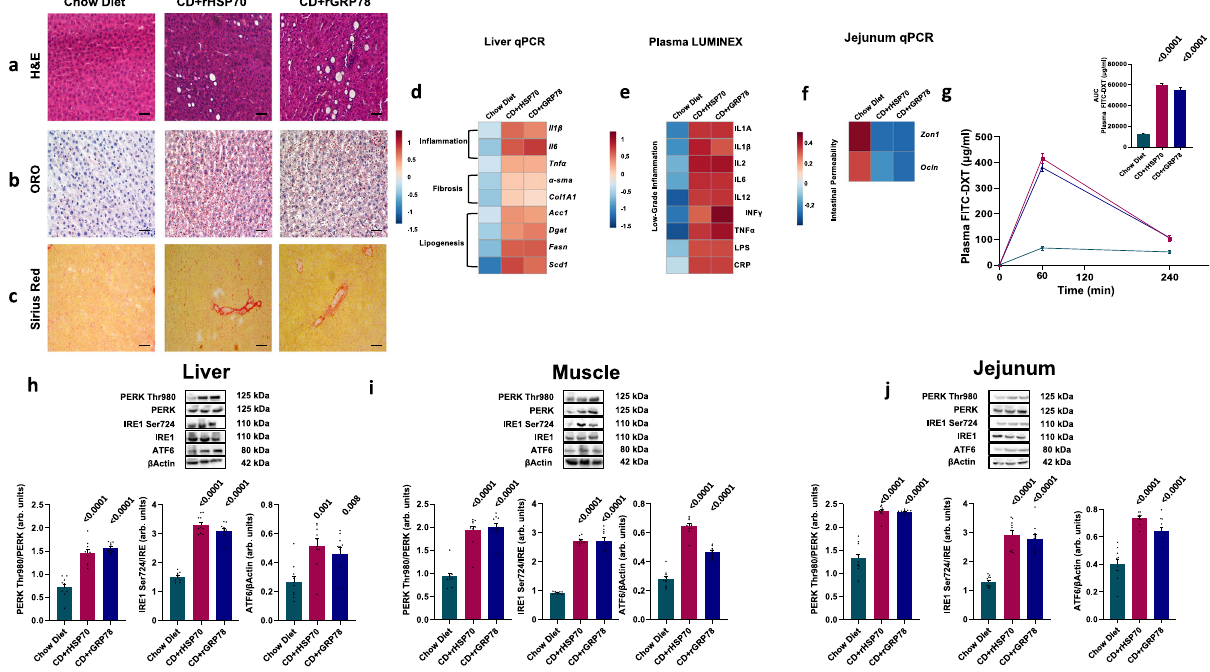
Fig. 3 | Effects of continuous infusion of HSP70 or GRP78 on NASH hallmarks. a – c Representative Hematoxylin and Eosin (H&E) ( a ), Oil Red O (ORO) ( b ), and Picro Sirius Red ( c ) staining of liver sections from rats under CD and infused with recombinant HSP70 or GRP78 or saline solution. d Gene expression of liver in fl ammation and fi brosis markers as well as key enzymes involved in hepatic de novo lipogenesis. e Plasma low-grade in fl ammation markers assessed by Luminex. f Gene expression of key genes involved in intestinal permeability. g Time course and AUC of in vivo intestinal permeability assessed by measuring Fluorescein